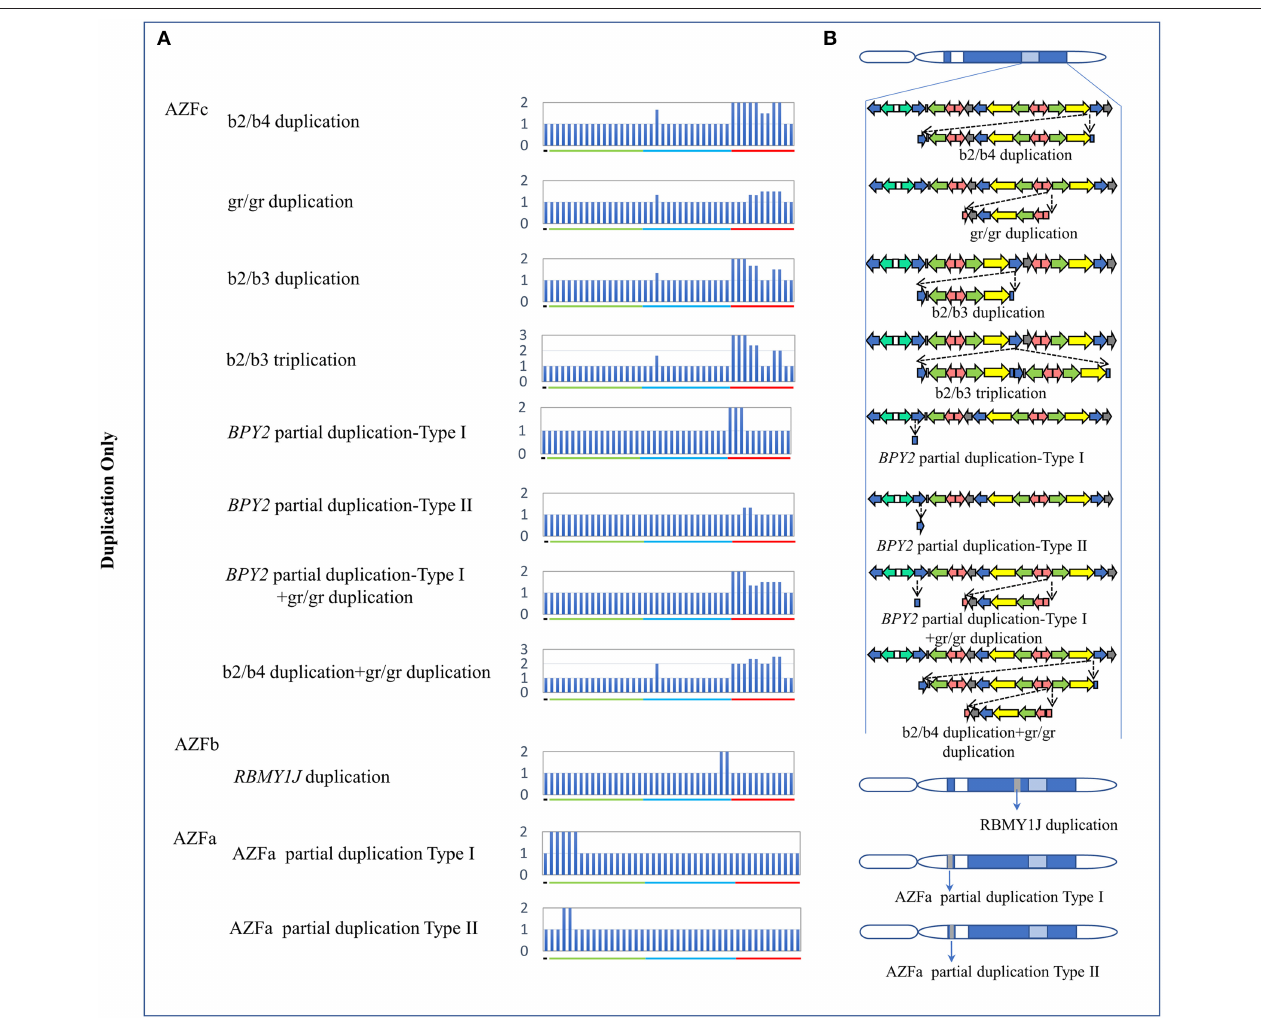
FIGURE 2 | CNVs (Duplication Only) in AZF regions of the human Y chromosome identified by MLPA. (A) Results of MLPA analysis. The relative peak area of each probe was calculated by dividing the actual peak area of the subject by the average of that of five reference samples. Increased relative peak areas mean copy-number duplications. (B) Corresponding structures and rearrangements of AZF